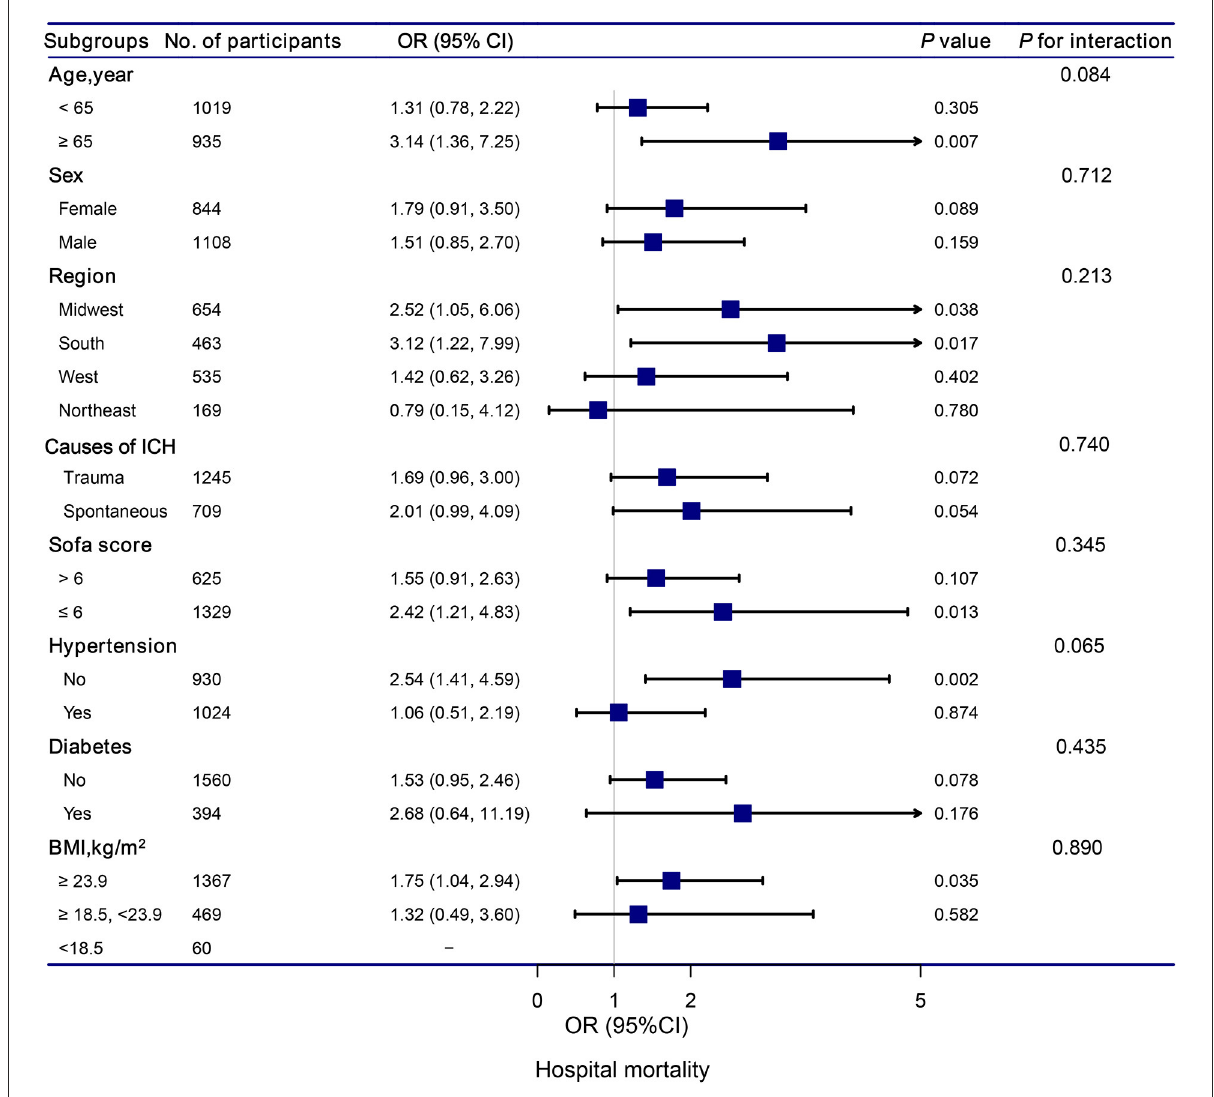
FIGURE2 Association between hypocalcemia and hospital mortality according to subgroup. Analyses were adjusted for gender, age, region, race, BMI, systolic blood pressure, diastolic blood pressure, white blood cell count, hemoglobin, platelet, glutamic-pyruvic transaminase, INR, prothrombin time, blood urea nitrogen, creatinine, magnesium, glucose, lactate, SOFA, trauma, first day vasopressor, first day sedative, hypertention, coronary artery disease, atrial fibrillation, congestive heart failure, diabetes, chronic pulmonary disease, and